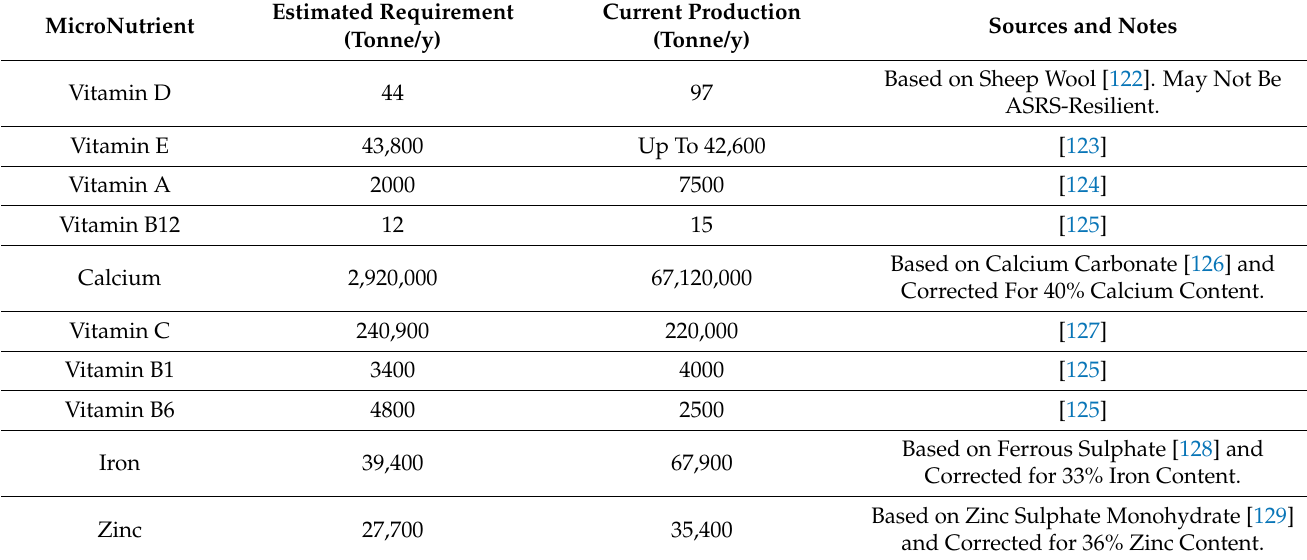
Table A3. Comparison of current production of micronutrients compared to the minimum required to fulfill the requirements of the global